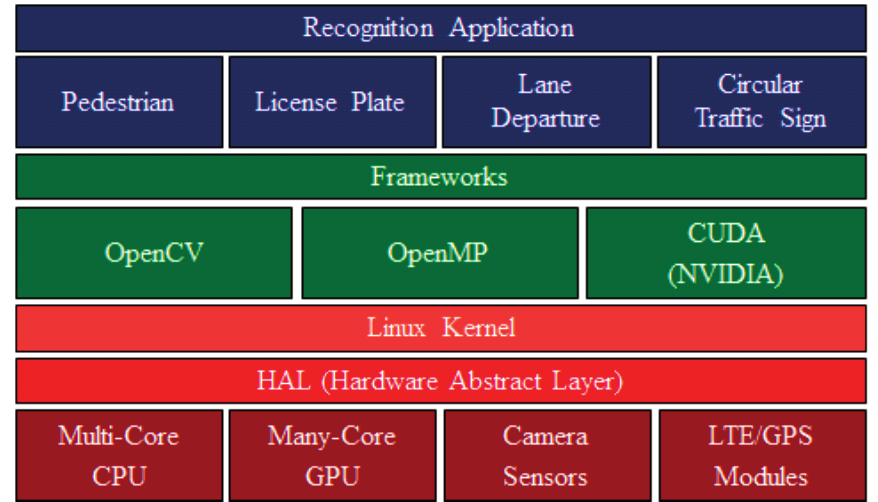
Figure 2. Software architecture of the proposed smart vehicular